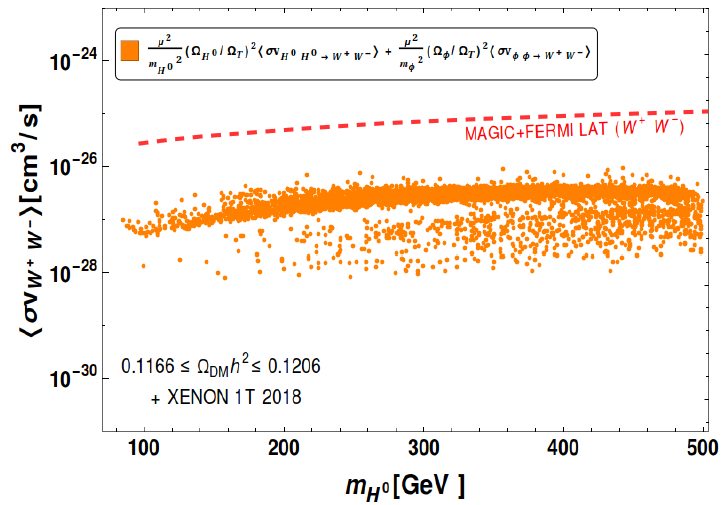
Figure 18 . E(cid:11)ective DM annihilations to W + W (cid:0) as de(cid:12)ned in eq. (7.4) in the two-component model for relic density and direct search allowed points compared against the latest indirect detec- tion bounds of Fermi-LAT